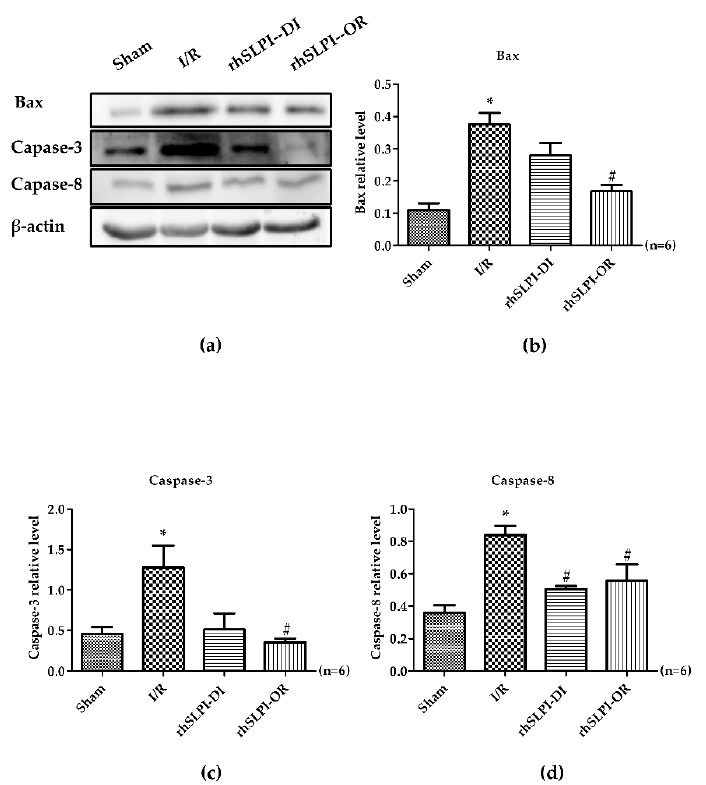
Figure 7. Determination of rhSLPI on apoptosis regulatory protein levels in MI rat by Western blot analysis ( a ). The quantitative analysis for the expression was presented for bax ( b ), caspase-3 ( c ) and caspase-8 ( d ) ( * p < 0.05 vs. sham) ( # p < 0.05 vs. I/R) ( n = 6).